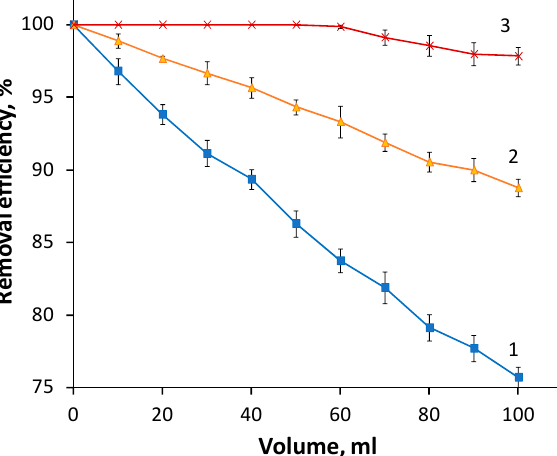
Figure 8. Efficiency of S. aureus removal from water as a function of the water volume passed through macroporous α -Al 2 O 3 ceramics (1), macroporous ceramics modified with AlOOH (2) and AlOOH/Ag (3).